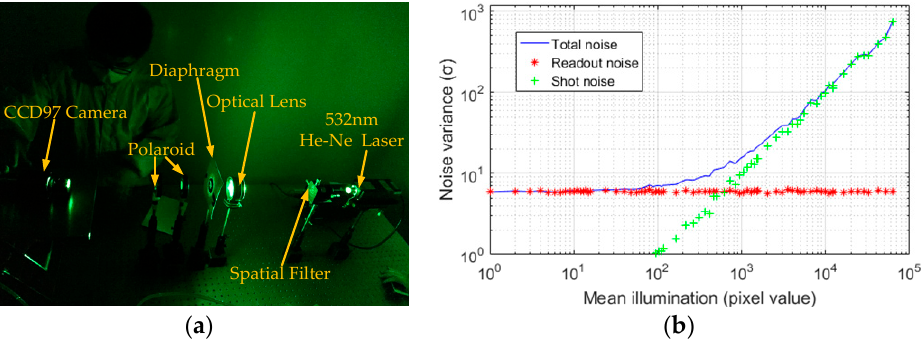
Figure 1. Real noise analysis for charge-coupled device (CCD) image sensor. ( a ) Experimental platform for noise analysis of CCD image sensor; ( b ) computed the Photon Transfer Curve (PTC) according to the measurement of [5,6].